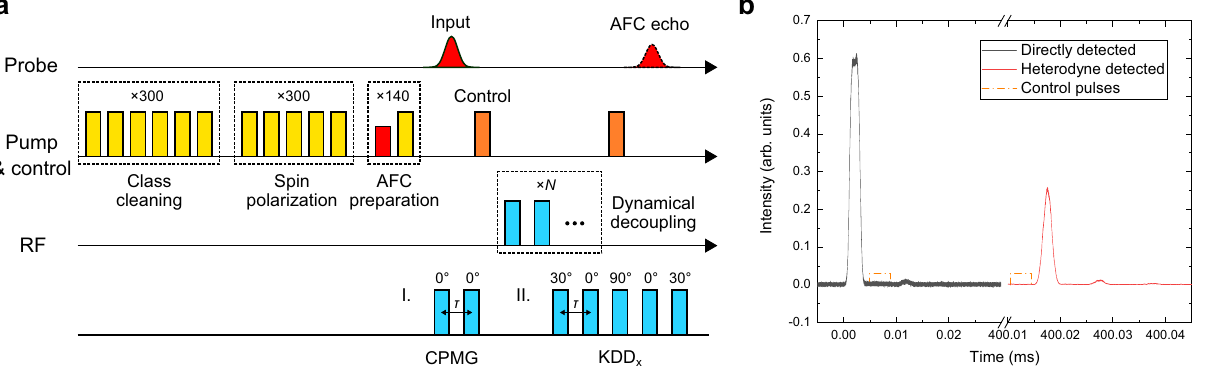
Fig. 2 Experimental sequence and oscilloscope traces. a The experimental sequence. The class-cleaning sequence containing six pump lights is used to pump away unwanted ions and select a single class of ions. The spin polarization sequence polarizes the population into the 3 j i g state. Then the AFC is prepared in the 3 j i g state while keeping the 4 j i g empty using the 4 j i g $ 3 j i e pump light. After the input pulse (Gaussian pro fi le, colored with red) is absorbed, a control pulse transfers the optical excitation into a spin-wave excitation for long-term storage. Dynamical decoupling is employed for protecting the spin coherence and fi nally the spin excitation is transferred back to the optical regime with another control pulse. Two kinds of dynamical decoupling sequences, CPMG and KDD x , are tested for spin coherence protection. b Oscilloscope traces of the spin-wave AFC storage with a CPMG sequence with τ = 100 ms, which consists of four π pulses. The black line shows the traces of transmission of the input mode and remaining two-level AFC echo, which are directly detected by the photodetector. The red line shows the trace of the spin-wave AFC echo after a storage of 400 ms, which is heterodyne detected. The traces are averaged four times. The dashed line indicates the position of the control